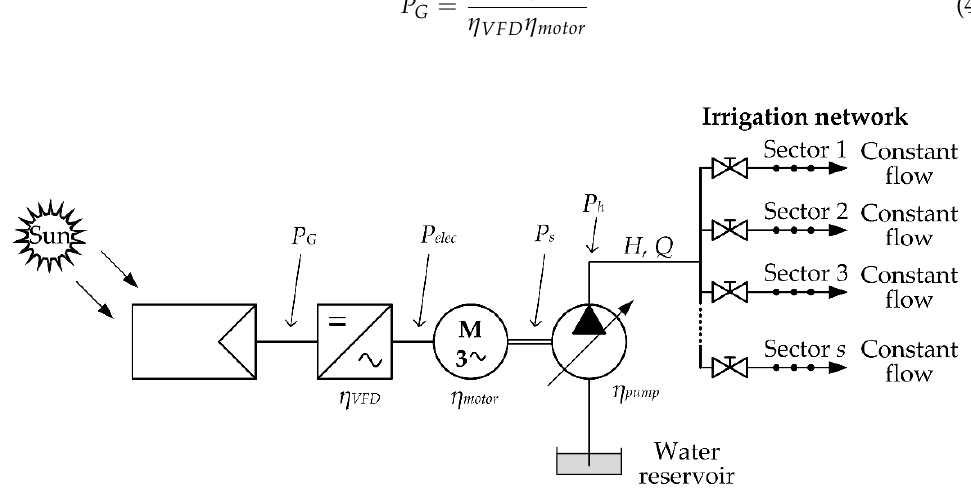
Figure 2. Scheme of the elements that make up the system under study in this work. These operating points correspond to the boundary values used by the management algorithm to order irrigation to a greater or lesser number of sectors. Table 1 shows the power demand matrix for s sectors. Table 1. Power demand matrix of the irrigation system for s sectors.